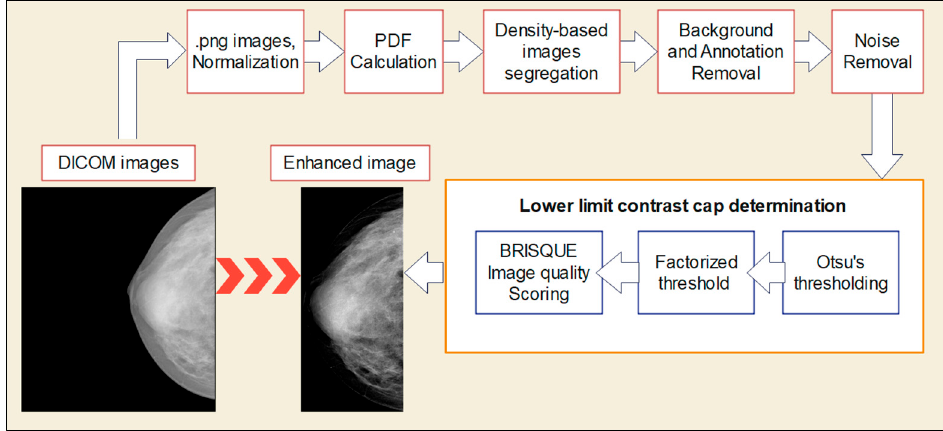
Figure 3. Stage 1: Proposed image SbBDEM technique as a pre-processing